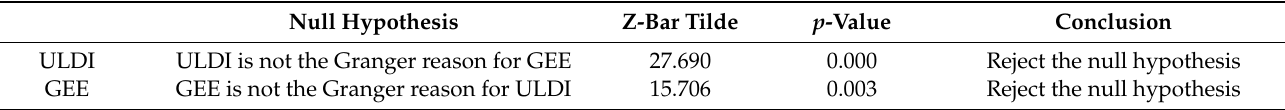
Table 4. Granger causality test results.